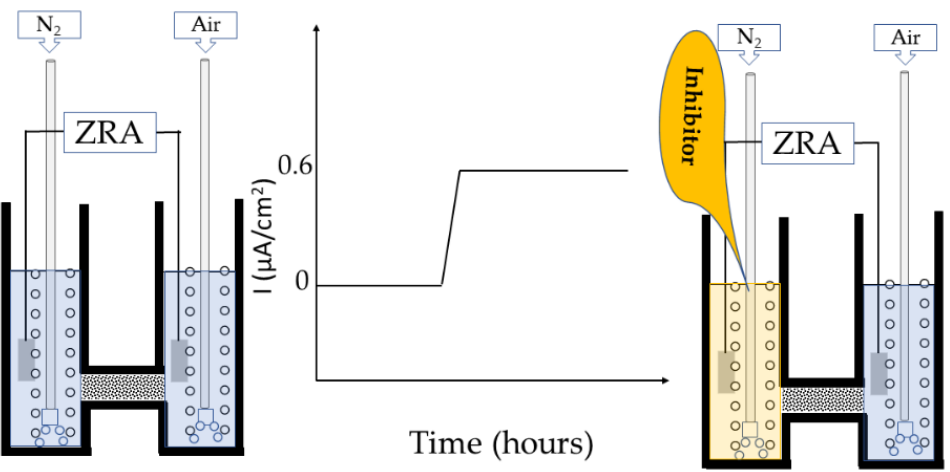
Figure 9. Split-cell electrochemical techniques.